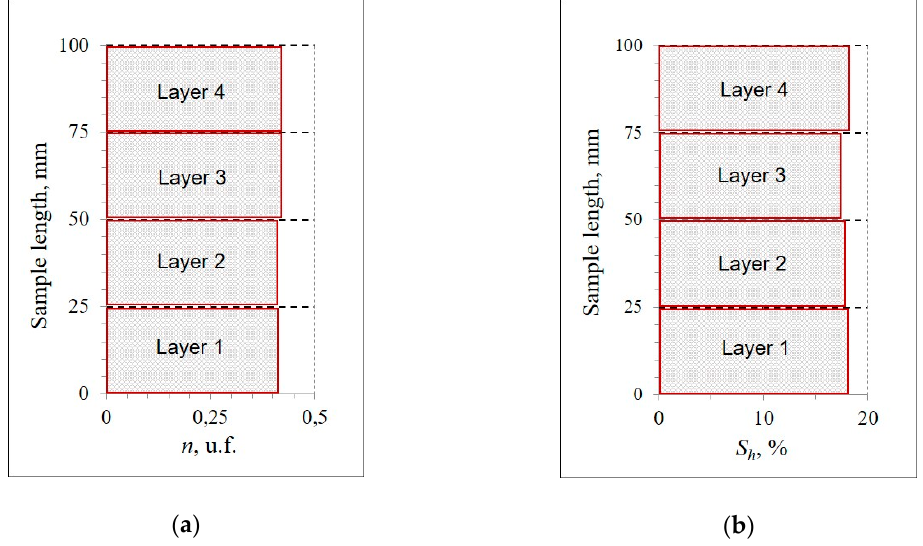
Figure 4. Porosity ( n , u.f.) and methane hydrate saturation ( S h , %) over sample height (fine sand with 7% of montmorillonite clay particles, W in = 10%). ( a ) Porosity distribution; ( b ) hydrate saturation distribution.